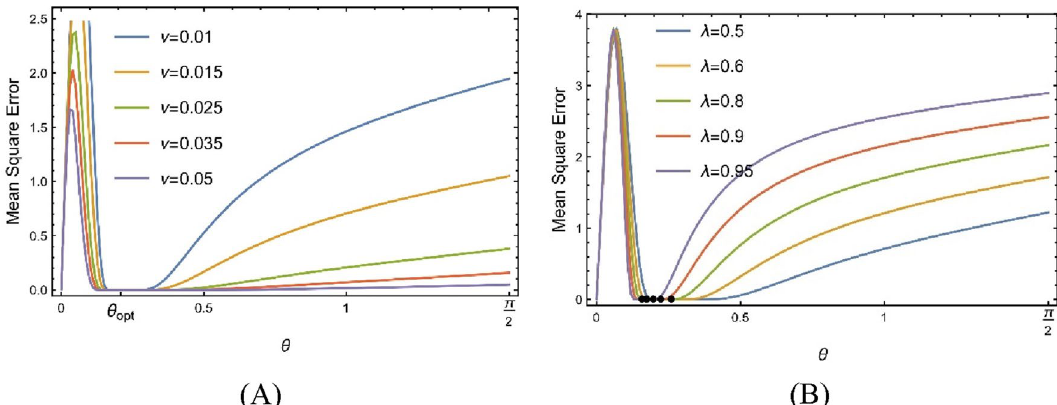
e − νπ x 2 e − ιπ (cid:31) x 2 , the graph of mean square error in the fractional Fourier series = 3 and ( A ) by taking (cid:31) = (cid:31)